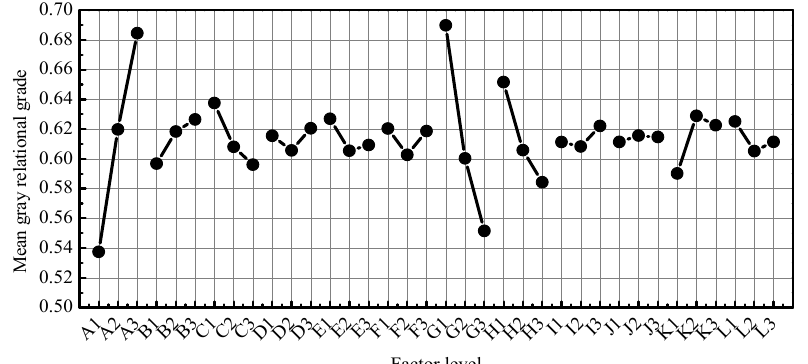
Figure 6. Main effects of factor levels.